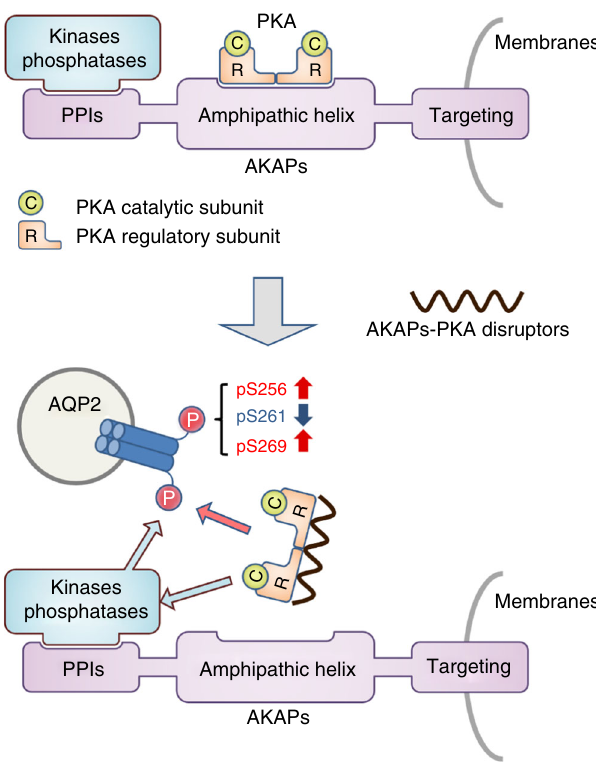
Fig. 6 Schematic summary of the effects of FMP-API-1 and its derivatives on AQP2. AKAPs generally contain protein-protein interactions (PPIs) sites, amphipathic helix domain, and targeting domain 48 . The amphipathic α -helix enables the anchoring of PKA holoenzymes. The targeting domain mediates the tethering of PKA complexes to selected subcellular